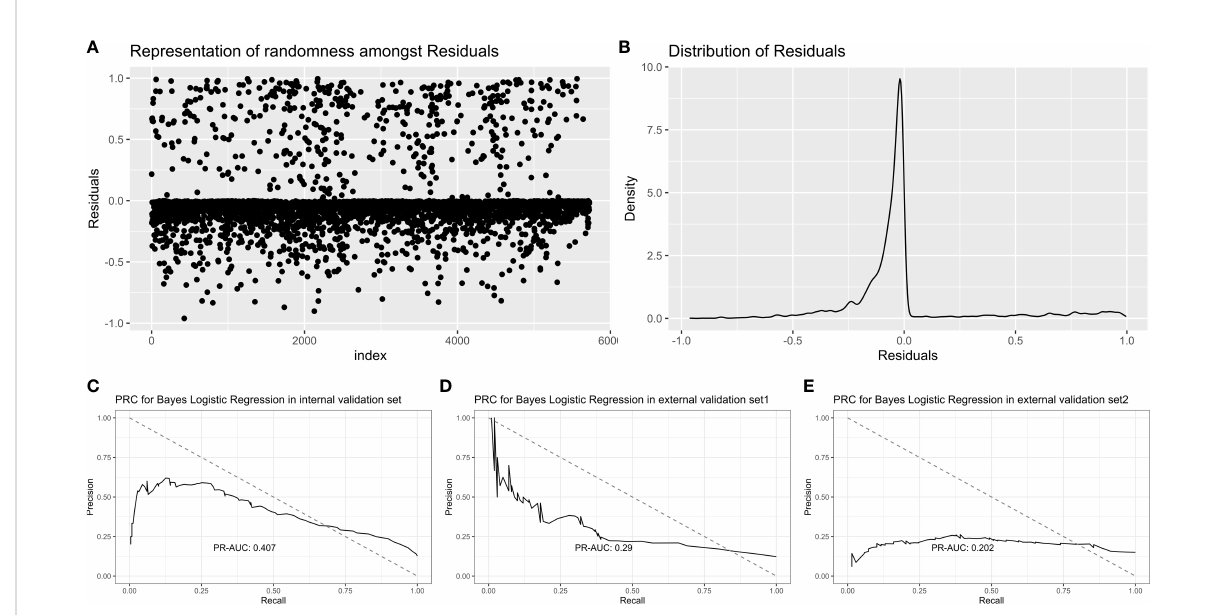
FIGURE 4 Representation of randomness among residuals (A) . Distribution of residuals (B) . PR-AUC for Bayes logistic regression in the internal validation set, the external validation set 1, and the external validation set 2 [from (C – E)